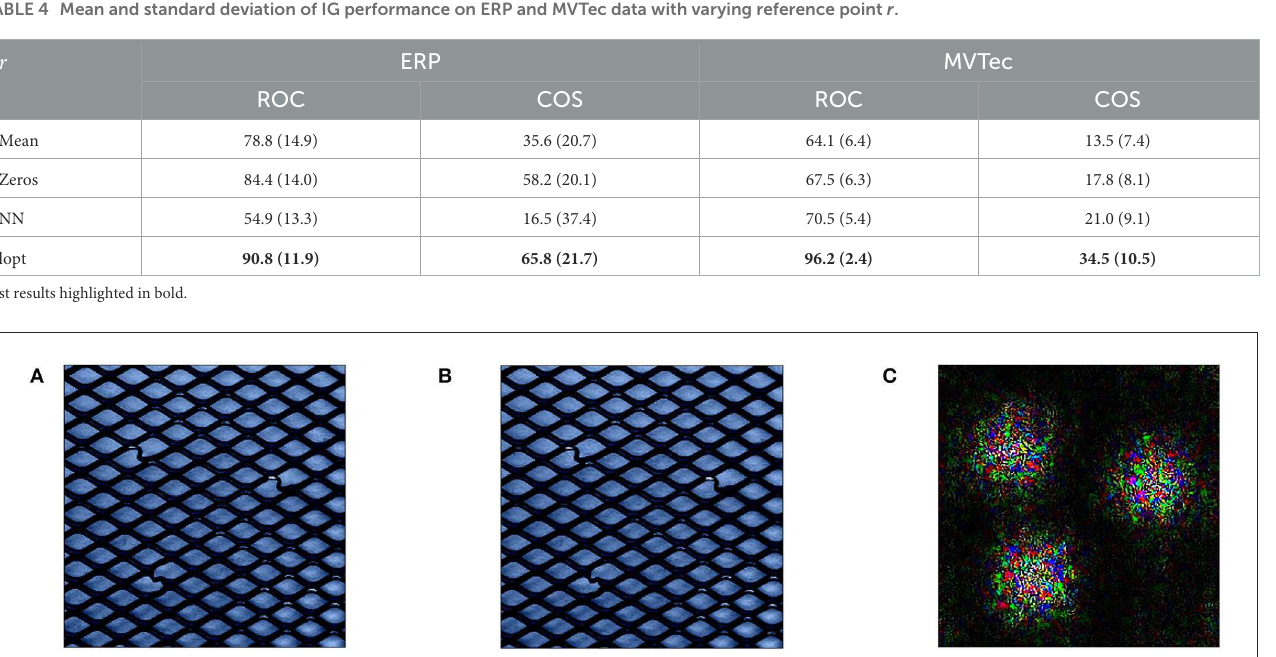
TABLE 4 Mean and standard deviation of IG performance on ERP and MVTec data with varying reference point r .